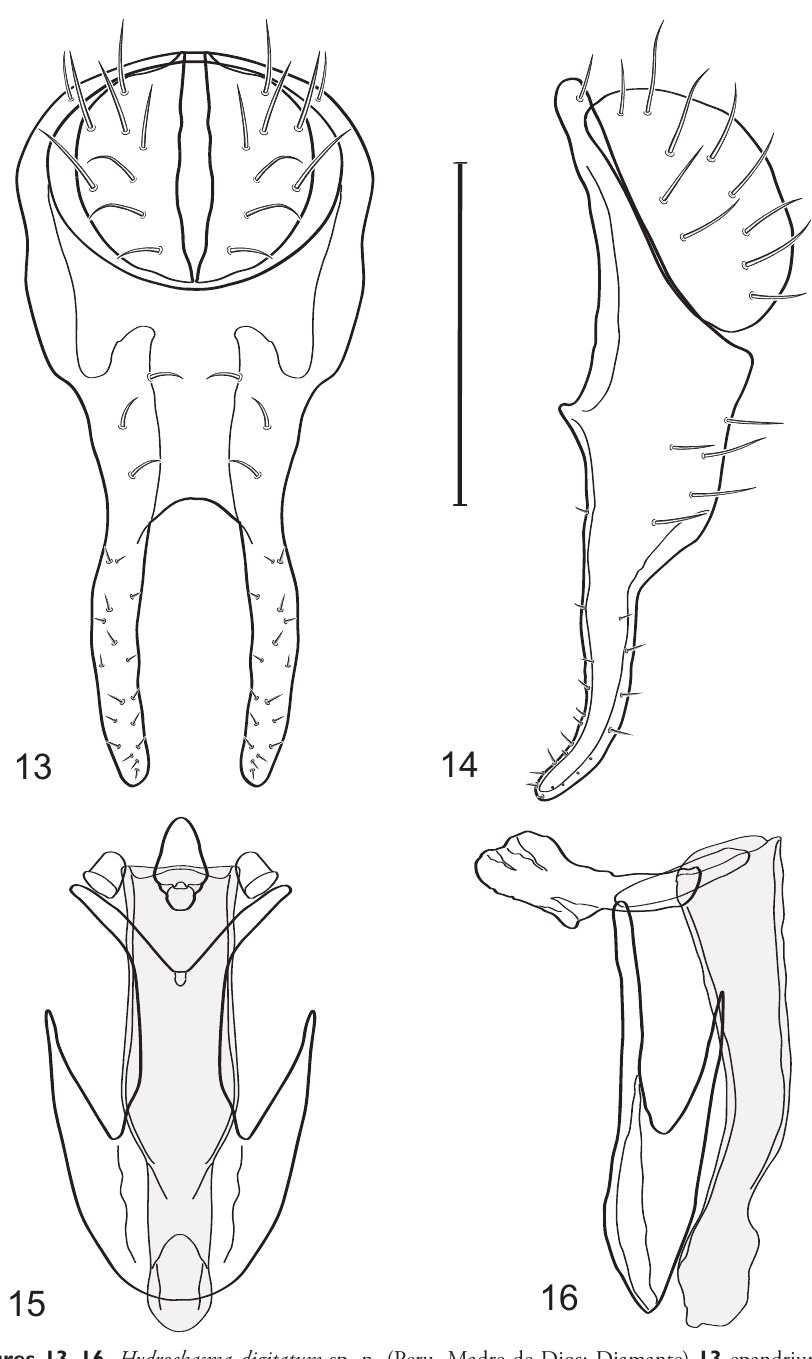
Figures 13–16. Hydrochasma digitatum sp. n. (Peru. Madre de Dios: Diamante) 13 epandrium and cerci, posterior view 14 same, lateral view 15 internal structures of male terminalia (aedeagus [shaded], phallapodeme, gonite, hypandrium), ventral view 16 same, lateral view. Scale bar = 0.1